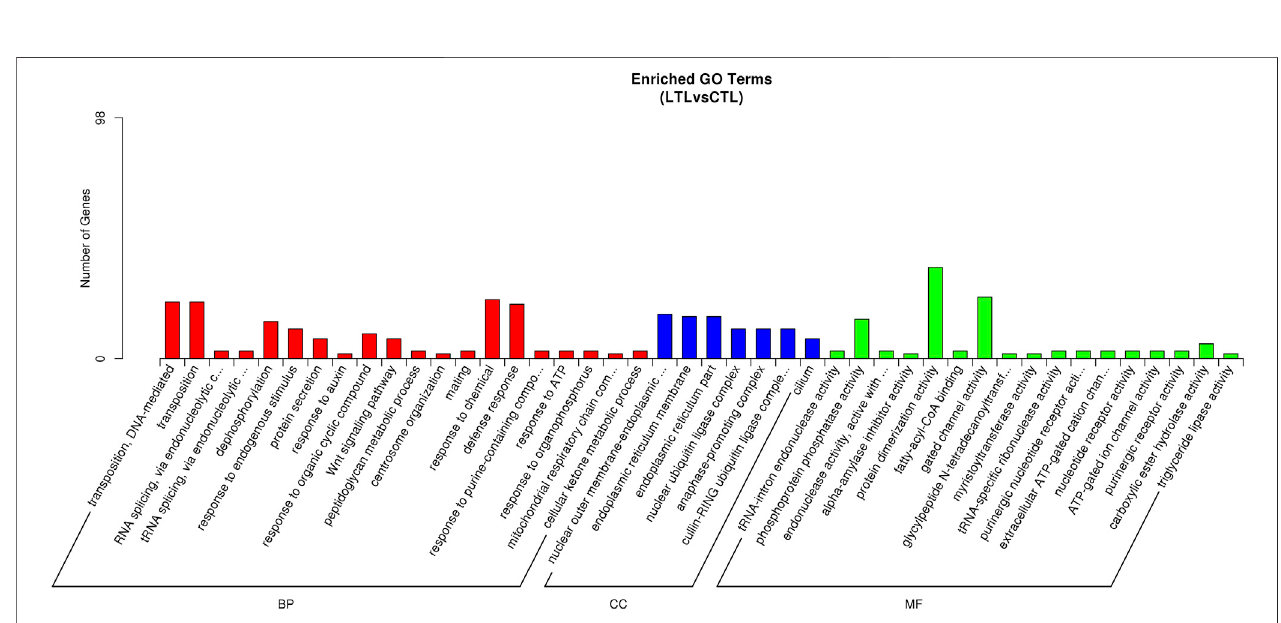
FIGURE 3 | GO classi fi cations of upregulated (A) and downregulated (B) DEGs.